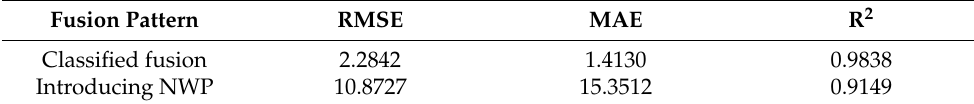
Figure 15. Predicted results with and without introducing NWP. Table 5. Predicted results with and without introducing NWP.